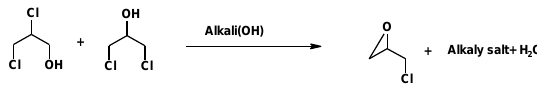
Figure 3. ECH synthesis by alkali treatment of 1,3-DCH.